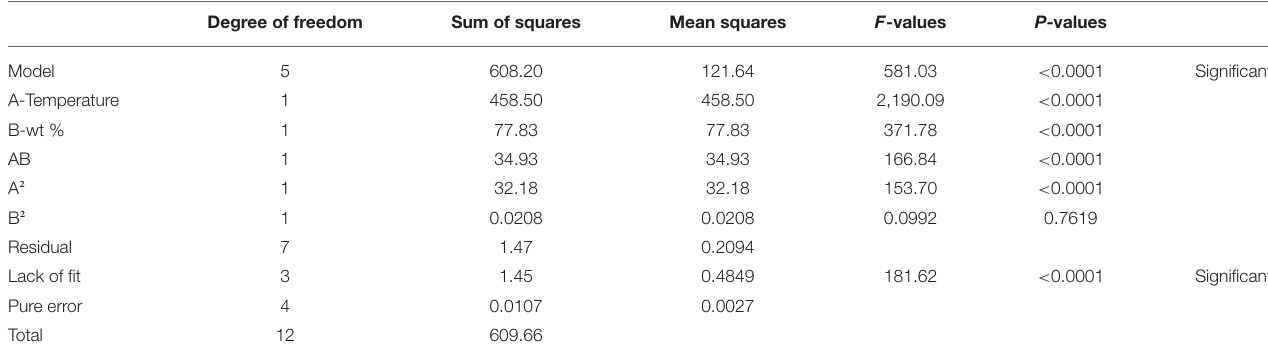
TABLE 2 | ANOVA results for